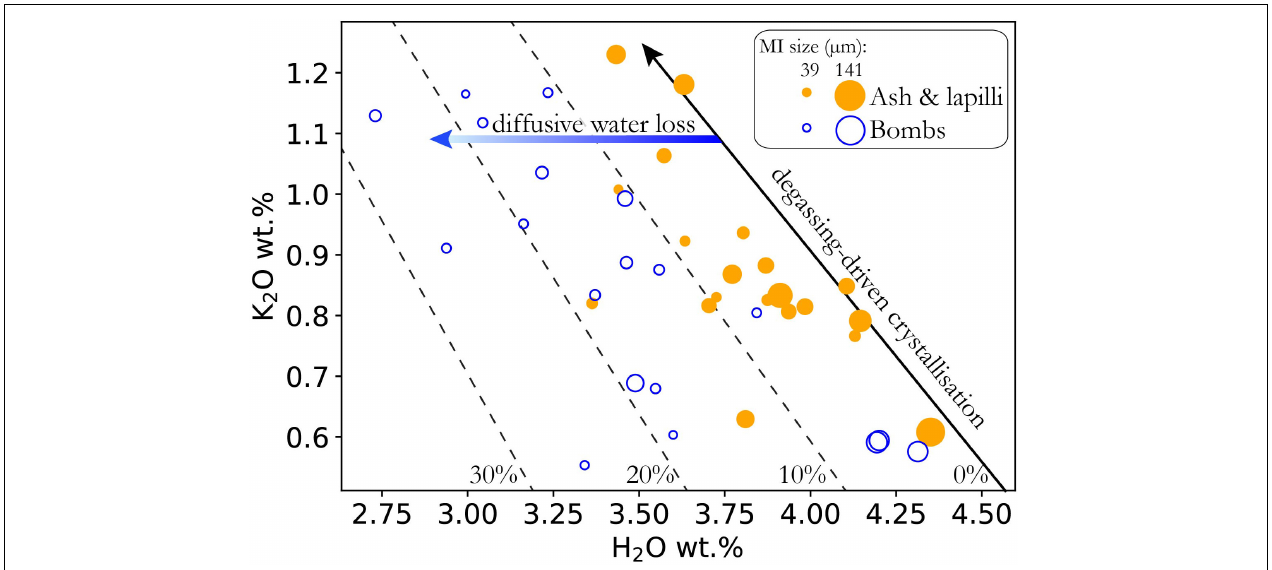
FIGURE 8 | K 2 O versus H 2 O for 1974 eruption of Fuego volcano, Guatemala (modified from Lloyd et al., 2013). Degassing-induced crystallization moves melt composition upward along the black arrow, modeled with Petrolog3 (Danyushevsky and Plechov, 2011) for starting composition of 0.5 wt% K 2 O, 4.45 wt% H 2 O, P i = 2.5 kbar, P f = 1.1 kbar, and decompressing at 30 bars/ ◦ C. Measured MI H 2 O is corrected back to this black line along blue arrow using measured K 2 O to infer pre-entrapment H 2 O content. Dashed lines show amount of re-equilibration [diffusive water loss/(initial water-final water)]. Marker size scaled to MI radius (see key). Radius calculated as the average of x,y,z, assuming z = y (see earlier discussion on melt inclusion size).